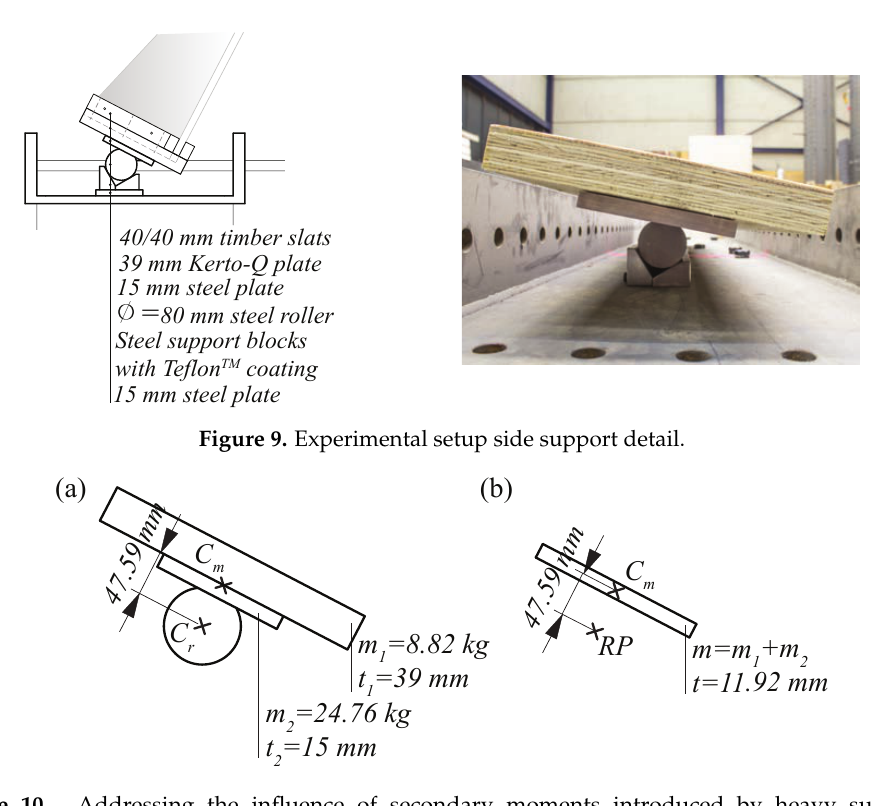
Figure 10. Addressing the influence of secondary moments introduced by heavy supports; ( a ) experimental setup supports with marked weight and thickness of the plates as well as center of mass, C m , and center of rotation, C r ; ( b ) FE model with corresponding weight and equal distance to the center of rotation, defined as a reference point, RP .